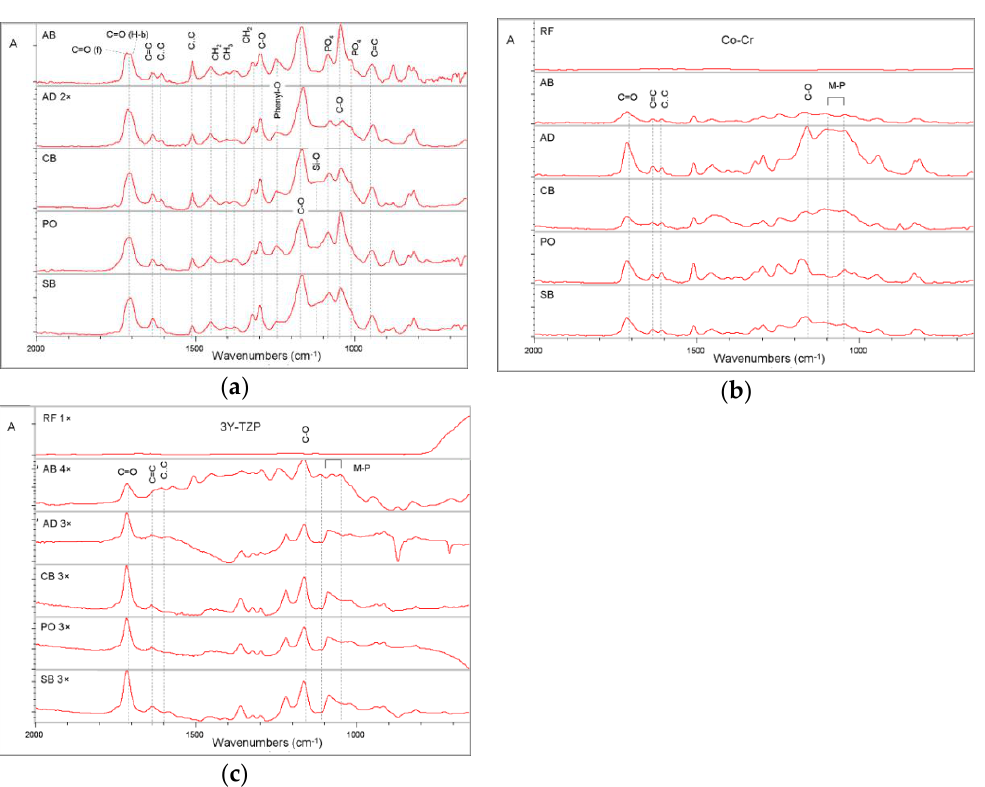
Figure 1. ( a ) Transmission FTIR spectra of reference adhesives, ( b ) Reflection infrared microscopy (RFTIRM) spectra of reference cobalt-chrome (Co-Cr) alloy before (RF) and after the adhesive treatments plus water and acetone rinsing, and ( c ) RFTIRM spectra of reference zirconia (3Y-TZP) before (RF) and after the adhesive treatments plus water and acetone rinsing. Note the absence of peaks from reference Co-Cr and 3Y-TZP spectra, the peaks assigned to metal-phosphate derivatives (M-P) and the greater contribution of these peaks on the Co-Cr alloy surface (absorbance scale, 2000–650 cm − 1 wavenumber range, expanded absorbance scale where indicated).